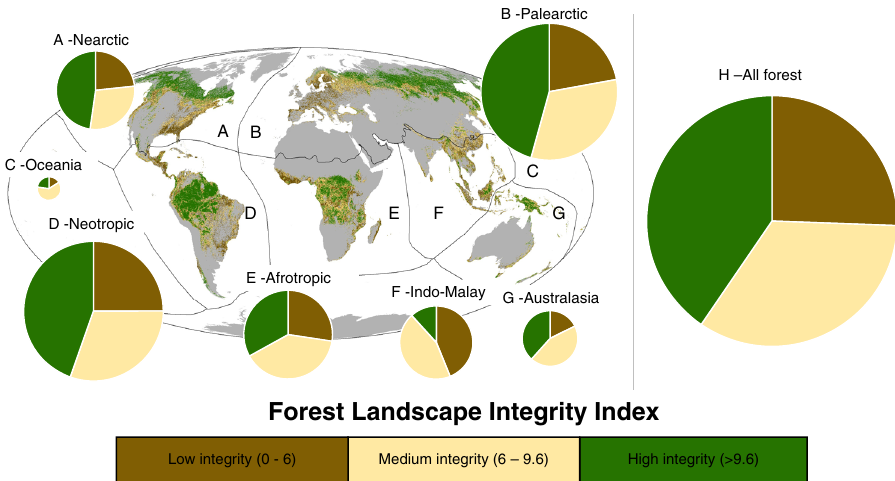
Fig. 3 Forest Landscape Integrity Index map categorized into three illustrative classes. The Forest Landscape Integrity Index for 2019 categorized into three broad, illustrative classes and mapped across each biogeographic realm ( a – g ). The size of the pie charts indicates the relative size of the forests within each realm ( a – g ), and h shows all the world ’ s forest combined. Table 1 Brief title: Forest Landscape Integrity Index scores for each biogeographic realm. Biogeographic realm Historical forest